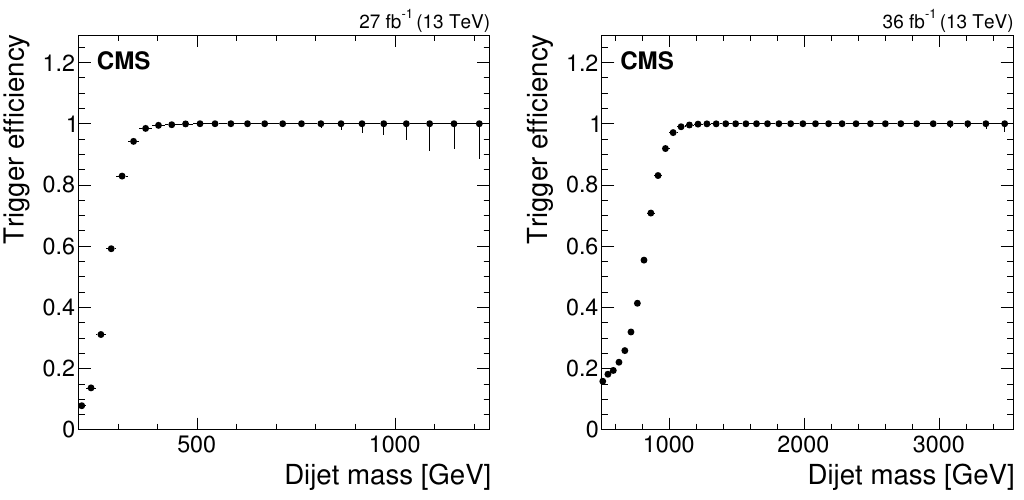
Figure 1 . The e(cid:14)ciency of the trigger for the low-mass search (left) and the high-mass search (right) as a function of dijet mass for wide jets, de(cid:12)ned in section 2.5, after all jet calibrations and event selections discussed in section 2. The horizontal lines on the data points show the variable bin